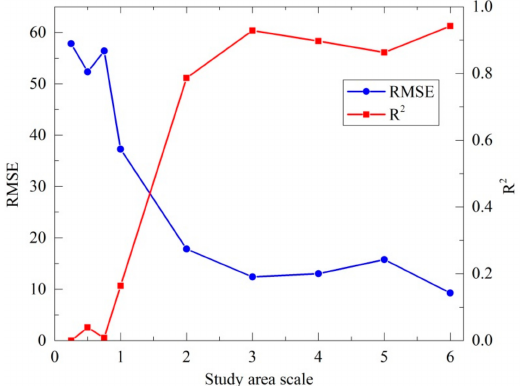
Figure 10. The R 2 adj and RMSE between FR S for the whole 2100 × 2100 grid simulated landscape and the standard deviation of TSLF ages for all 201 TSLF maps at each of the nine study area